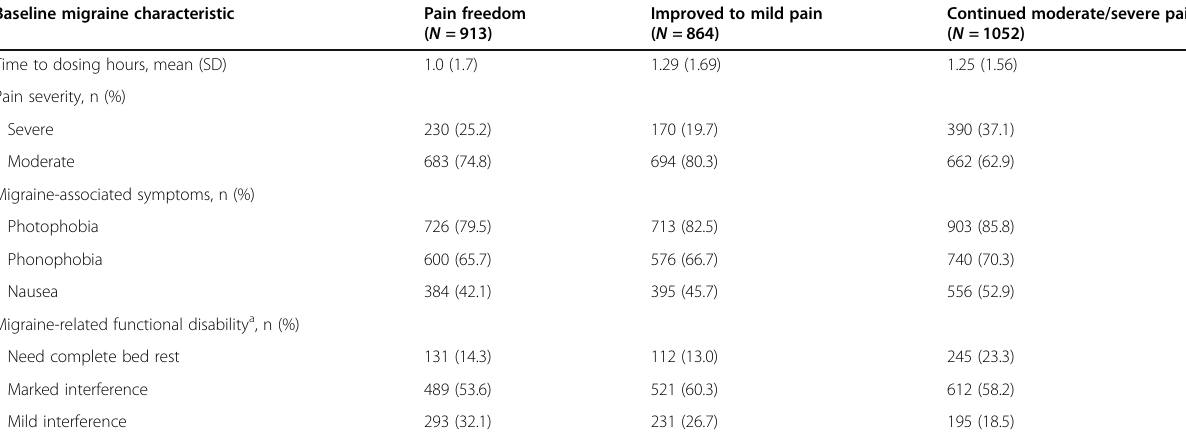
Table 2 Baseline migraine characteristics by head pain outcome group at 2 h post-dose Baseline migraine